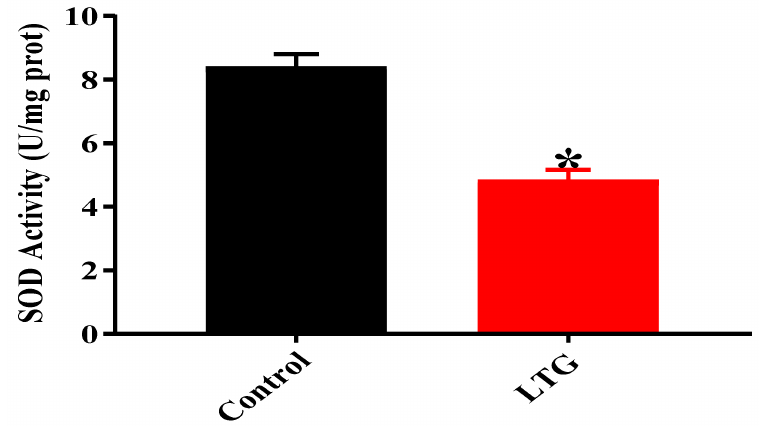
Figure 4. E ff ect of Pb acetate administration on SOD activity in the cerebellums of rats after Pb toxicity induction. Data are expressed as mean ± SEM ( n = 3); * p < 0.005 vs. control.